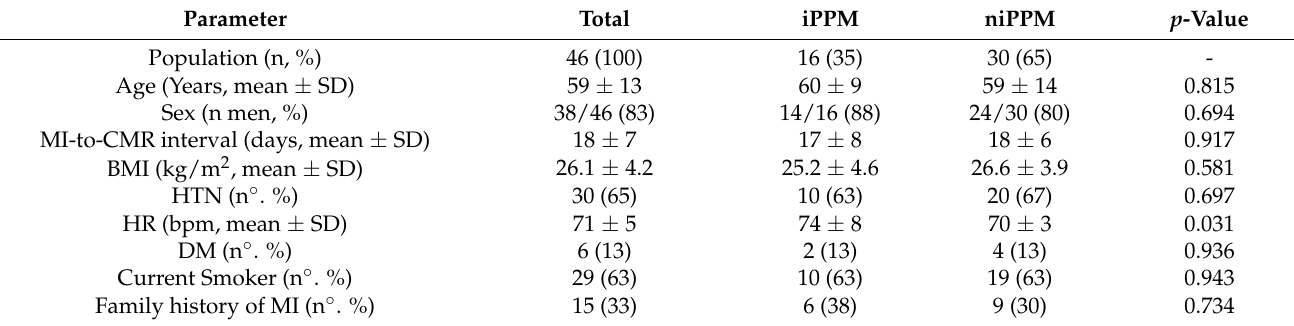
Table 1. The patients’ characteristics and clinical data.